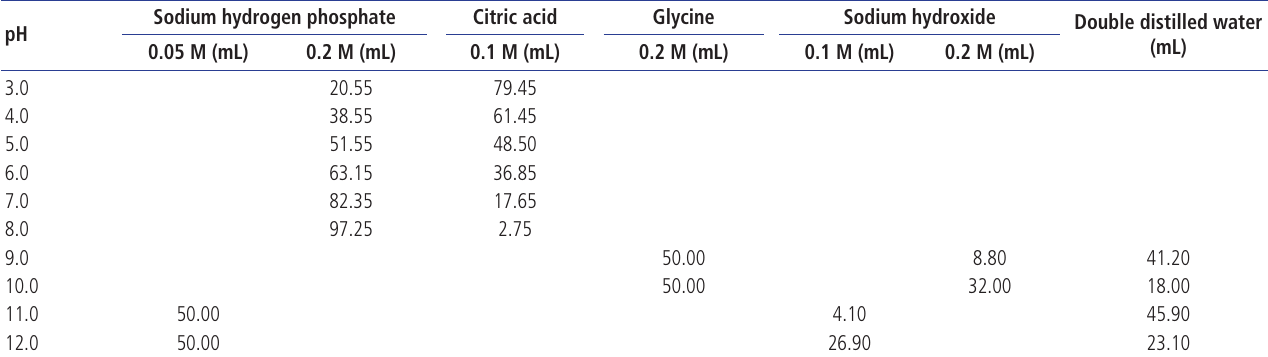
Table 1. Different formulations (100 mL) of complex solutions developed in this study Sodium hydrogen phosphate pH